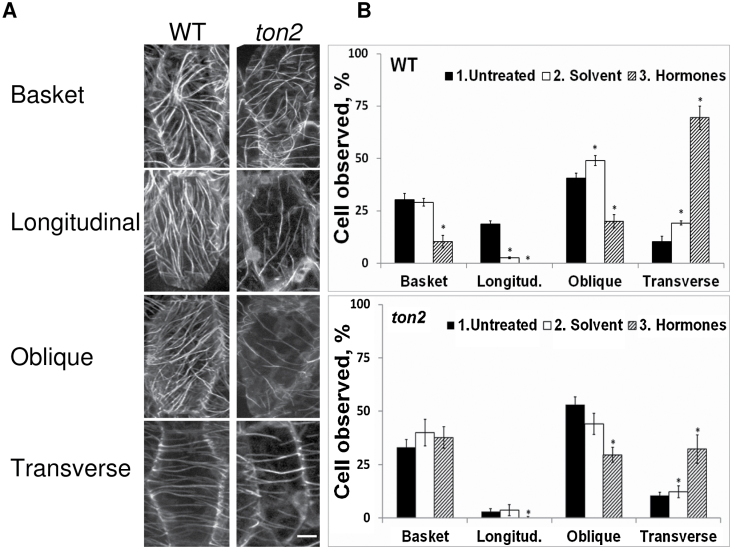
Cortical microtubule array reorganization in ton2 epidermal hypocotyl cells under treatment with hormones. (A) Different types of microtubule array organization in 4-day-old wild type and ton2 mutant cells. (B) Configurations of microtubule arrays before treatment (Untreated), after 2h treatment with a control solution containing hormone solvent (Solvent), and after 2h of GA4/IAA treatment (Hormones). Bar=10 µm. 30 cells from 6 different plants were analysed. *, P<0.05 for differences with untreated plants. The Angle Tool from ImageJ was used to measure orientations of microtubule bundles relative to the longitudinal cell axis. Microtubule arrays with more than 75% of microtubule bundles oriented at 0–19° were classified as longitudinal, microtubules oriented at 20–64° were classified as oblique, and microtubules oriented at 65–115° were classified as transverse.